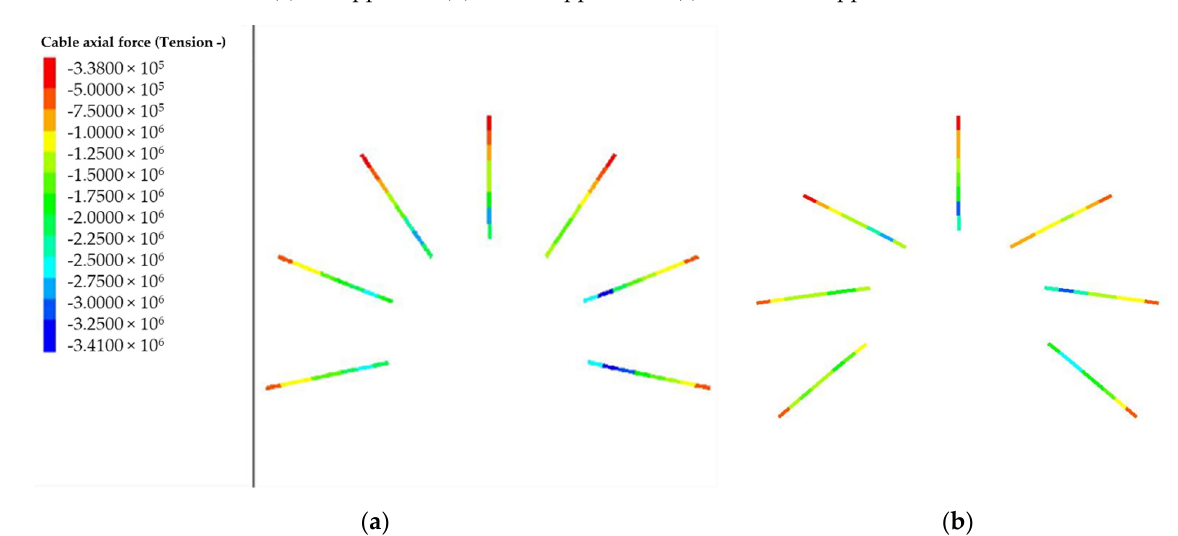
Figure 11. Failure zone distributions of the rock mass around the roadway of the support face: ( a ) unsupported, ( b ) radial support, and ( c ) non-radial support.